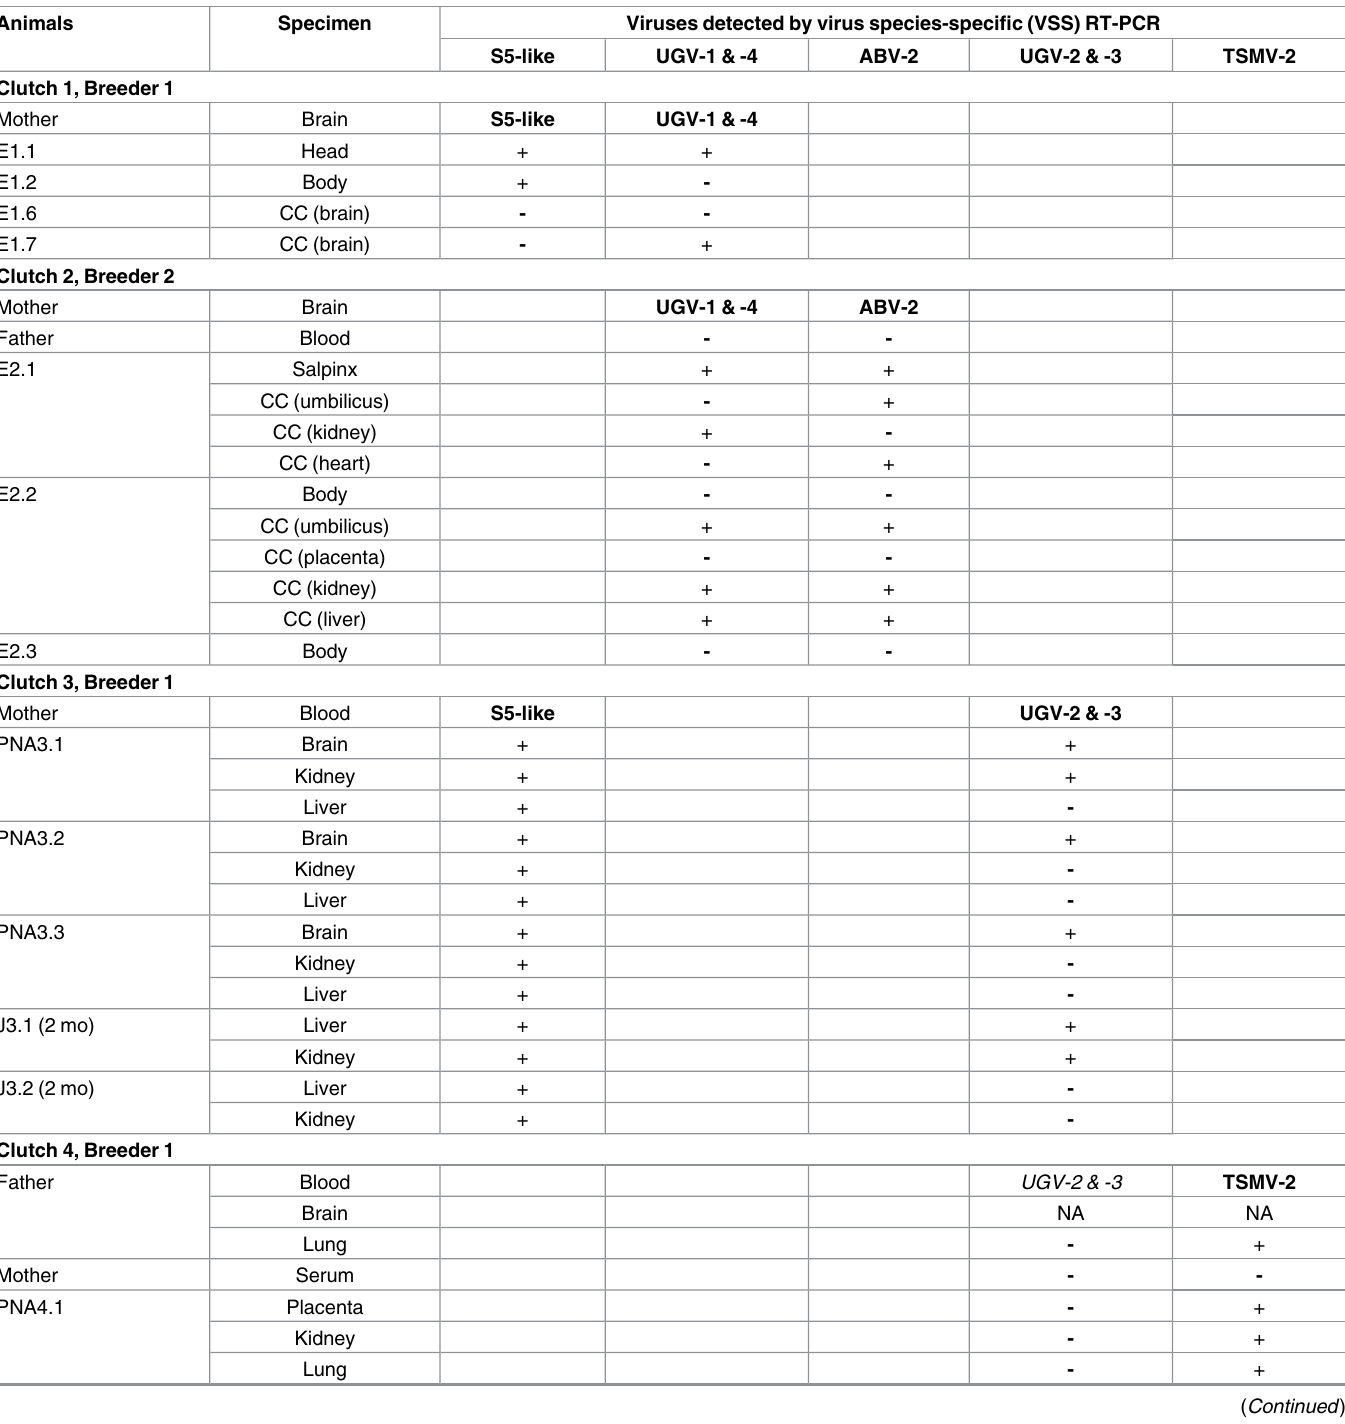
Table 3. Detailed results obtained from the different specimens used for the RT-PCR approach to identify S segments (abbreviations and acces- sion codes are given in S1 Table, and in materials and methods) in each animal in clutches 1–5. The virus genomes de novo assembledfrom